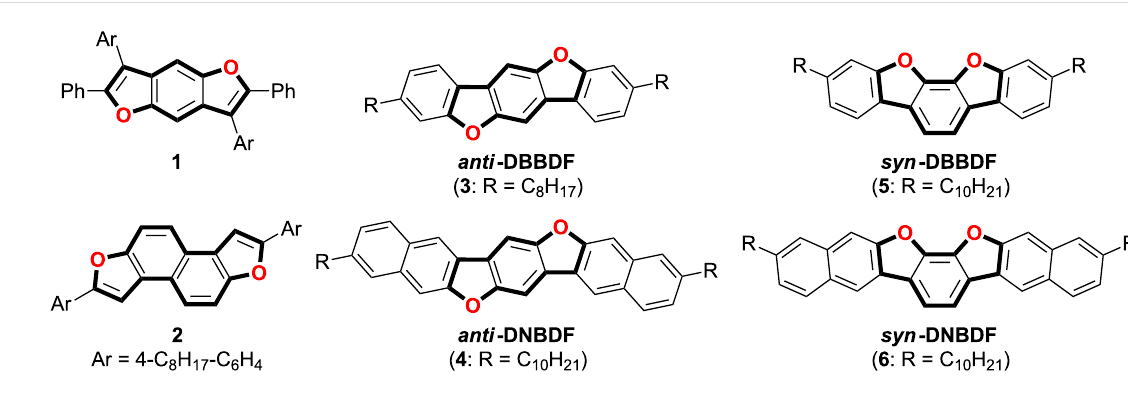
Figure 1: Structures of furan-fused ladder-type π -conjugated compounds.